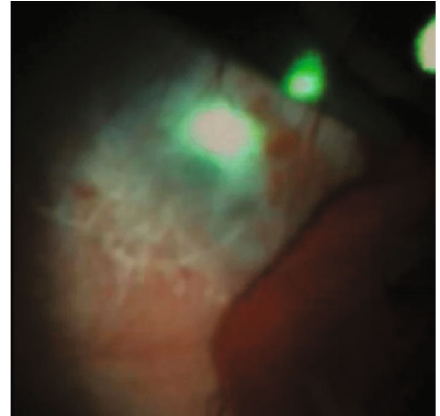
Figure 5: (F-URS) the infundibulum of diverticulum the calyceal diverticulum incised upper.